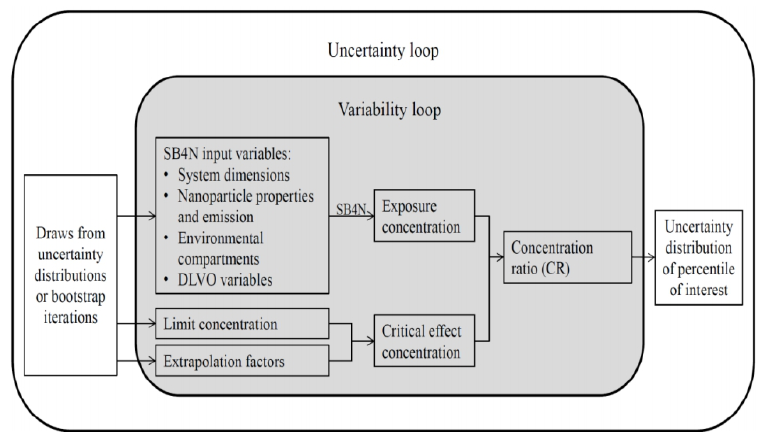
Fig. 3. A schematic diagram of uncertainty and variability loops in the two-dimensional Monte Carlo design used in